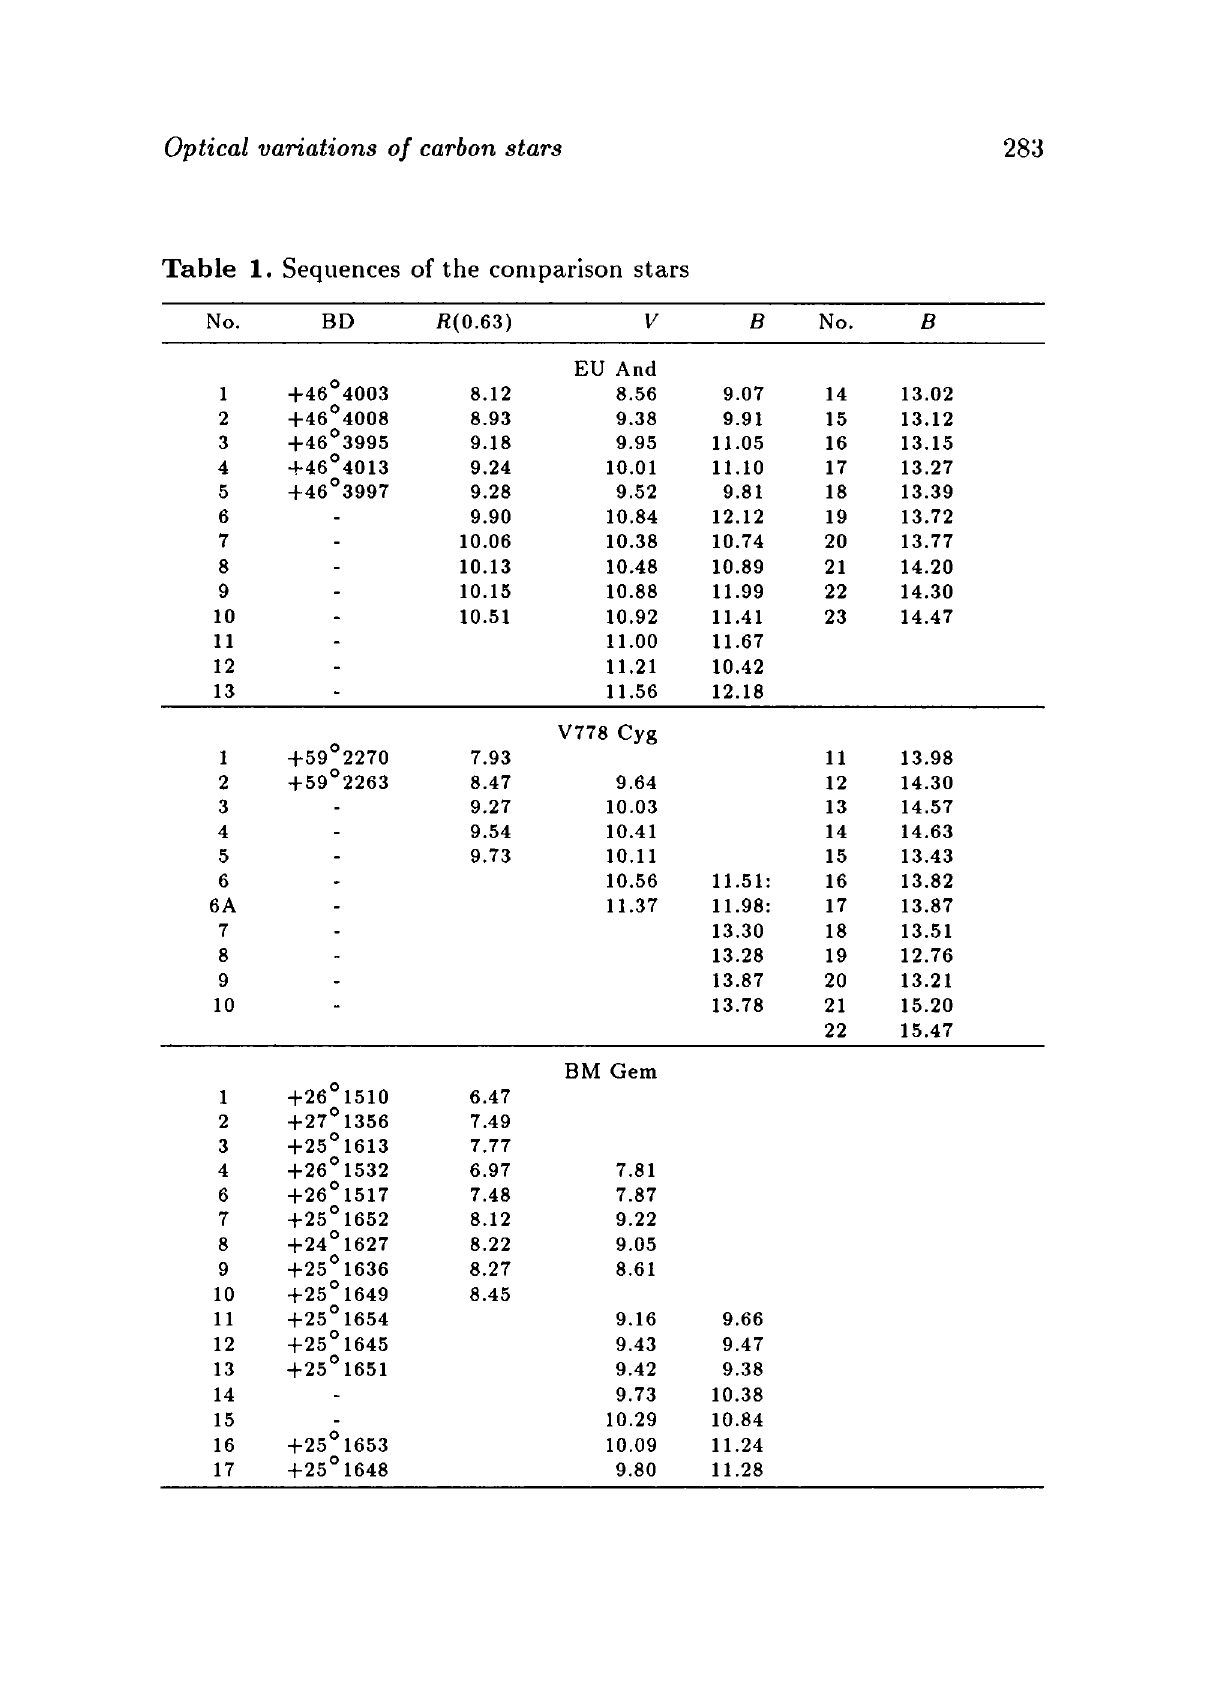
Table 1. Sequences of the comparison